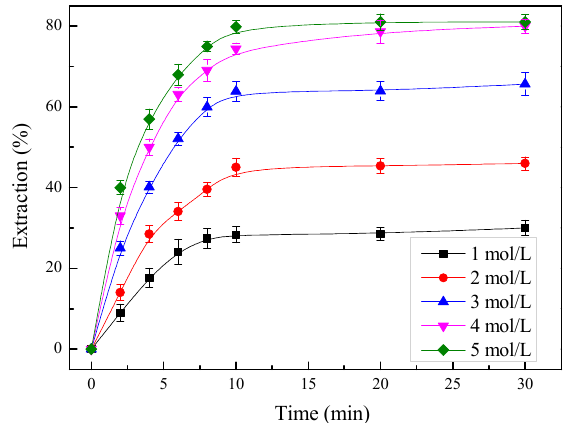
Figure 11. Effect of the total ammonia concentration on the zinc extraction at a temperature of 35 ° C. To estimate the order of the reaction with respect to the total ammonia concentration, the plots of 1 − (1 − α ) 2/3 − (2/3) α vs. t and ln k d vs. ln[NH 3 ] T were utilized, as shown in Figure 12. An order of the reaction with respect to the total ammonia concentration of 1.53 was estimated with the correlation coefficient (R 2 ) being 0.98249.